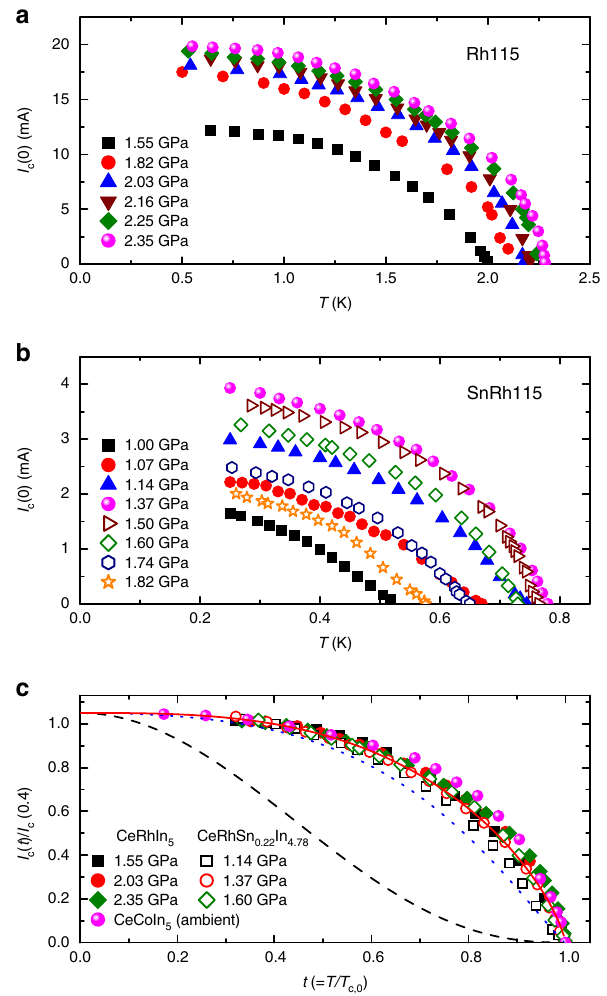
Fig. 2 Temperature dependences of the zero- fi eld critical current for Ce- based heavy fermion materials under pressure. a Temperature dependence of the zero- fi eld critical current, I c (0), for CeRhIn 5 at various pressures. b Zero- fi eld I c for CeRhSn 0.22 In 4.78 at various pressures. c Reduced temperature ( t = T / T c,0 ) dependence of I c , I c ( t ), normalized by its value at t = 0.4 for Rh115 and SnRh115 at representative pressures and for CeCoIn ambient pressure. The normalized values of I c ( P , t ) for all crystals can be described by a single curve, I c ( t ) ∝ (1 − t 2 ) 5/6 (1 + t 2 ) 2/3 , indicating universal behavior of I c ( t ) with respect to pressure in the Ce M In 5 ( M = Co, Rh) materials. Dotted and dashed curves are for δ T c -pinning and δ l -pinning, respectively, as discussed in the dependence of the zero- fi eld critical current, I c (0), for Rh115 and SnRh115 at several pressures, respectively. Here, I c is determined by using the voltage criterion of 0.1 μ V (see Supplementary Fig. 2). Analysis of the fl ux-pinning force, F p = I c × μ 0 H , shows